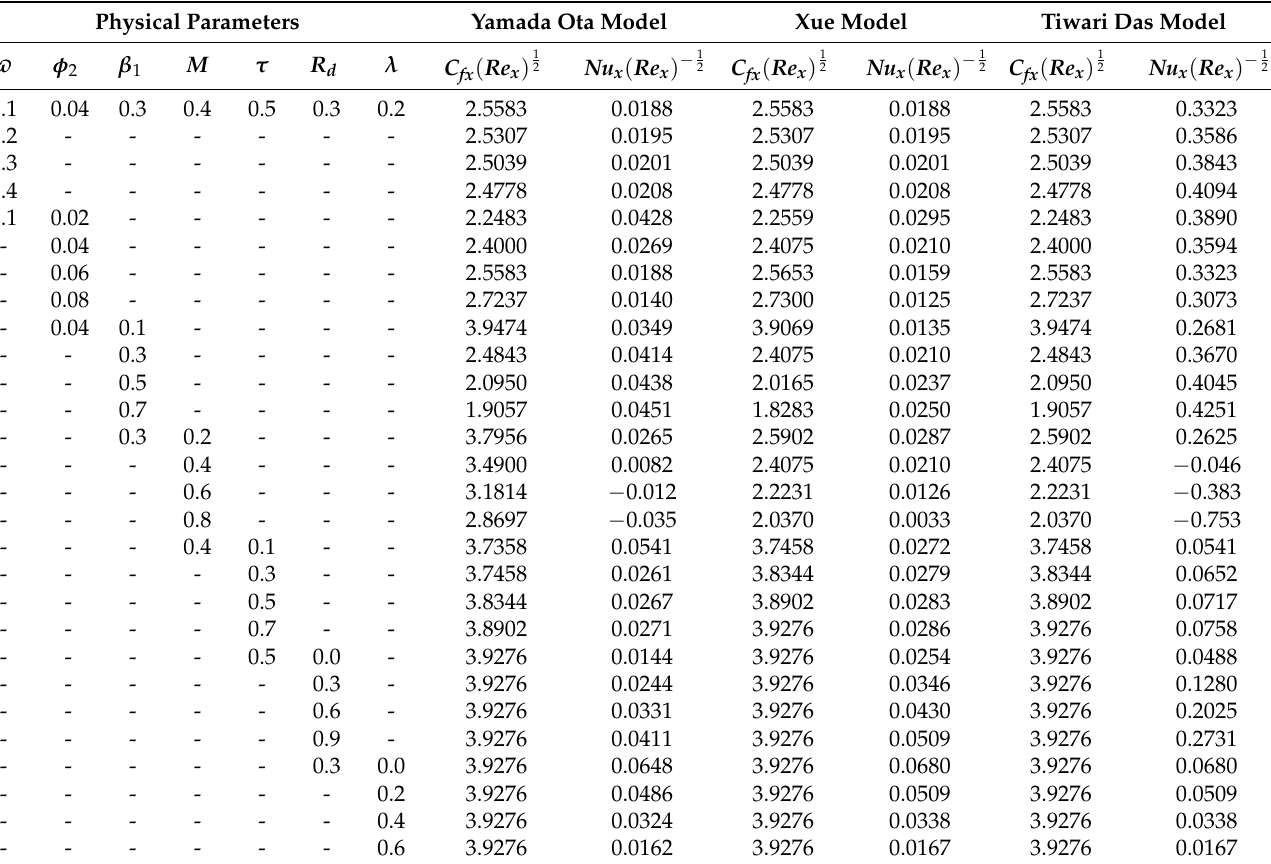
Table 4. Numerical analysis of skin friction and Nusselt number for different values of parameters.